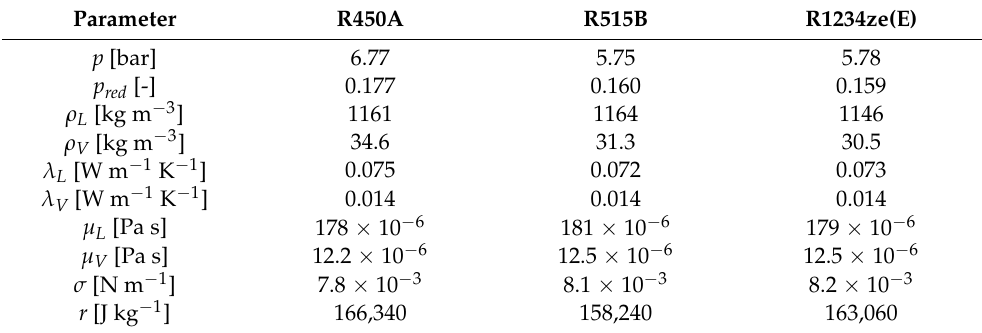
Table 3. Thermophysical properties of R450A, R515B, and R1234ze(E) at a saturation temperature of 30 ◦ C.